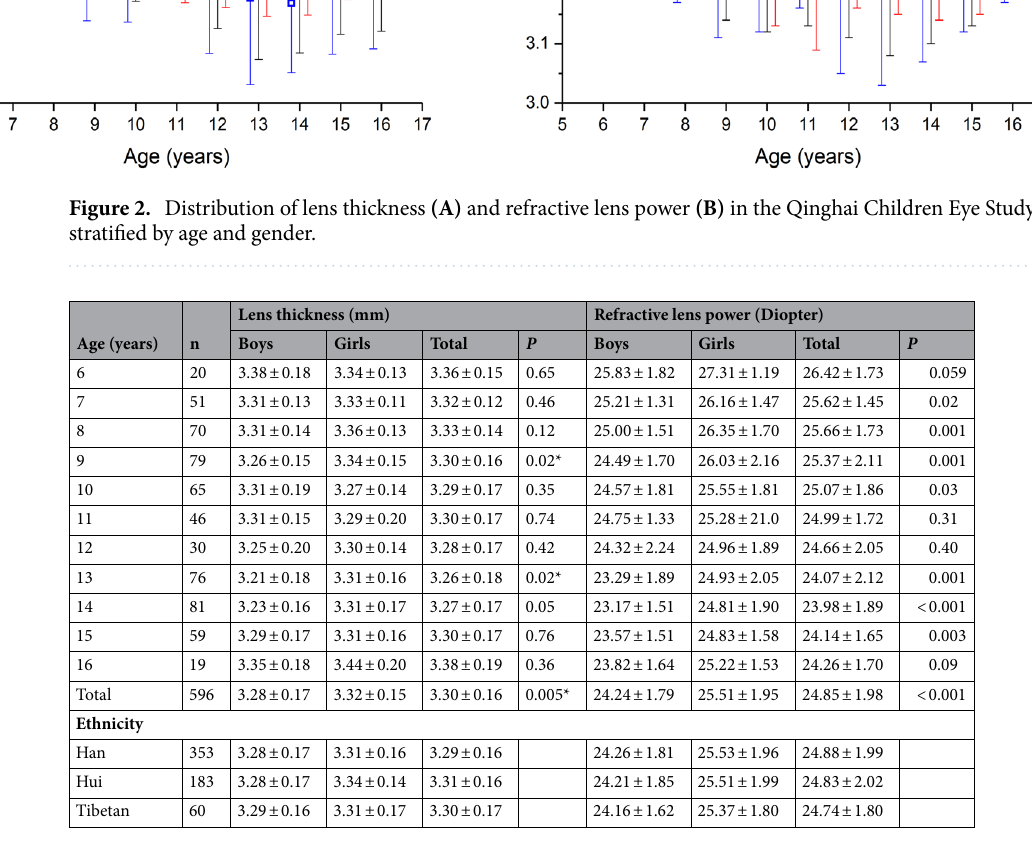
Table 2. The Lens thickness (mean ± standard deviation) and refractive lens power (mean ± standard deviation) in the Qinghai Children Eye Study, stratified by age, gender and